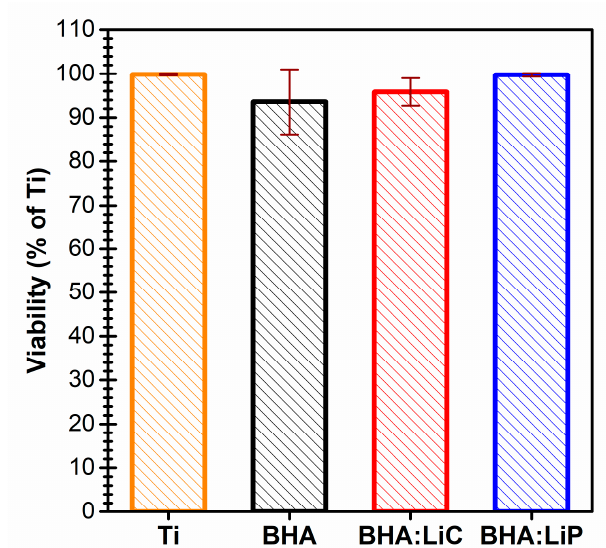
Figure 8. Cellular viability of human mesenchymal stem cells after 72 h of growth on the surface of Ti, bovine hydroxyapatite (BHA), and doped BHA coatings synthesized by PLD using the same experimental conditions. Reprinted from Reference [60], with permission from Elsevier. Slight modifications of the acronyms from the original figure were done for uniformization with the sample codes used in this review.